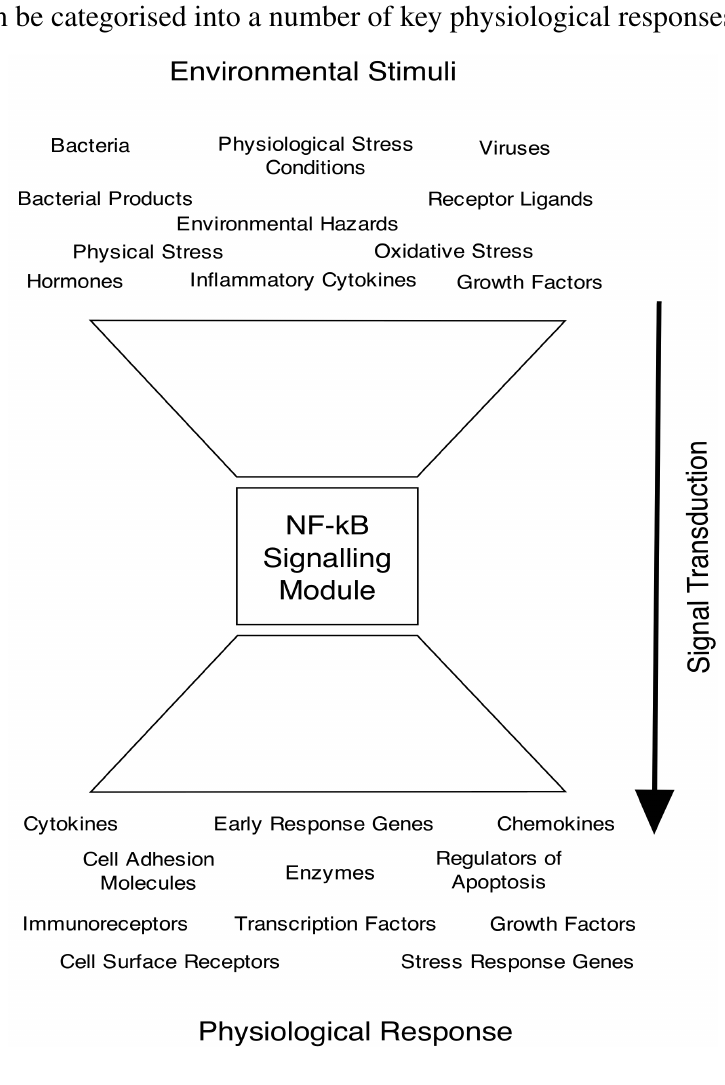
NF- κ B results in the induction of gene expression of a number of inflammatory response proteins, including the inhibitor I κ B α , thus providing a negative feedback mechanism that controls transient activation of the pathway. Figure 1. High-level representation of how the multitude of inducers of the NF- κ B signalling pathway, which converge on the NF- κ B signalling module (NF- κ B, I κ B α and IKK), before diverging to regulate a multitude of gene products, has the topology of a bow-tie motif from systems